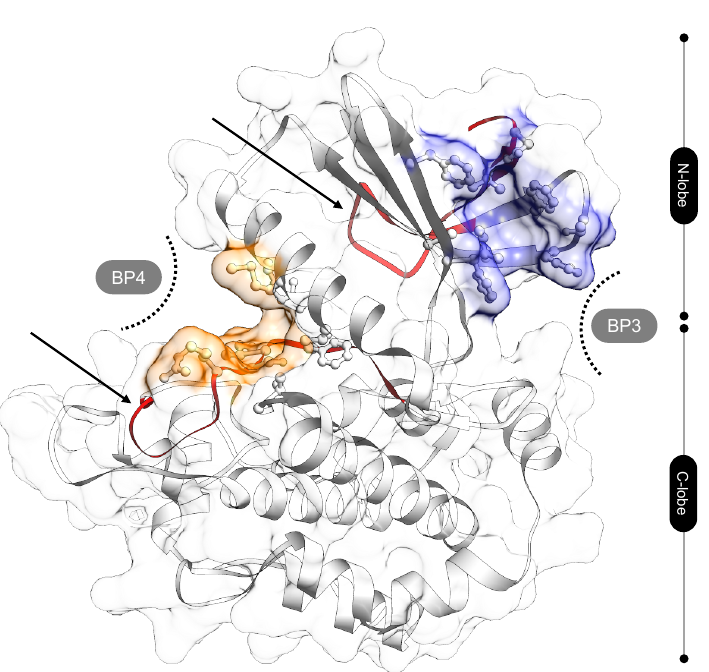
Figure 5. BP3 (in blue) and BP4 (in orange) binding sites on the kinase domain surface of MKK7, potentially occupable by DTP3. MKK-KD is shown in cartoon and surface representations. The residues defining the binding site are depicted in ball and stick representation. MKK7 linear pep- tides involved in the interaction with DTP3 [11] are reported as red ribbons (black arrows, residues 113–136 and